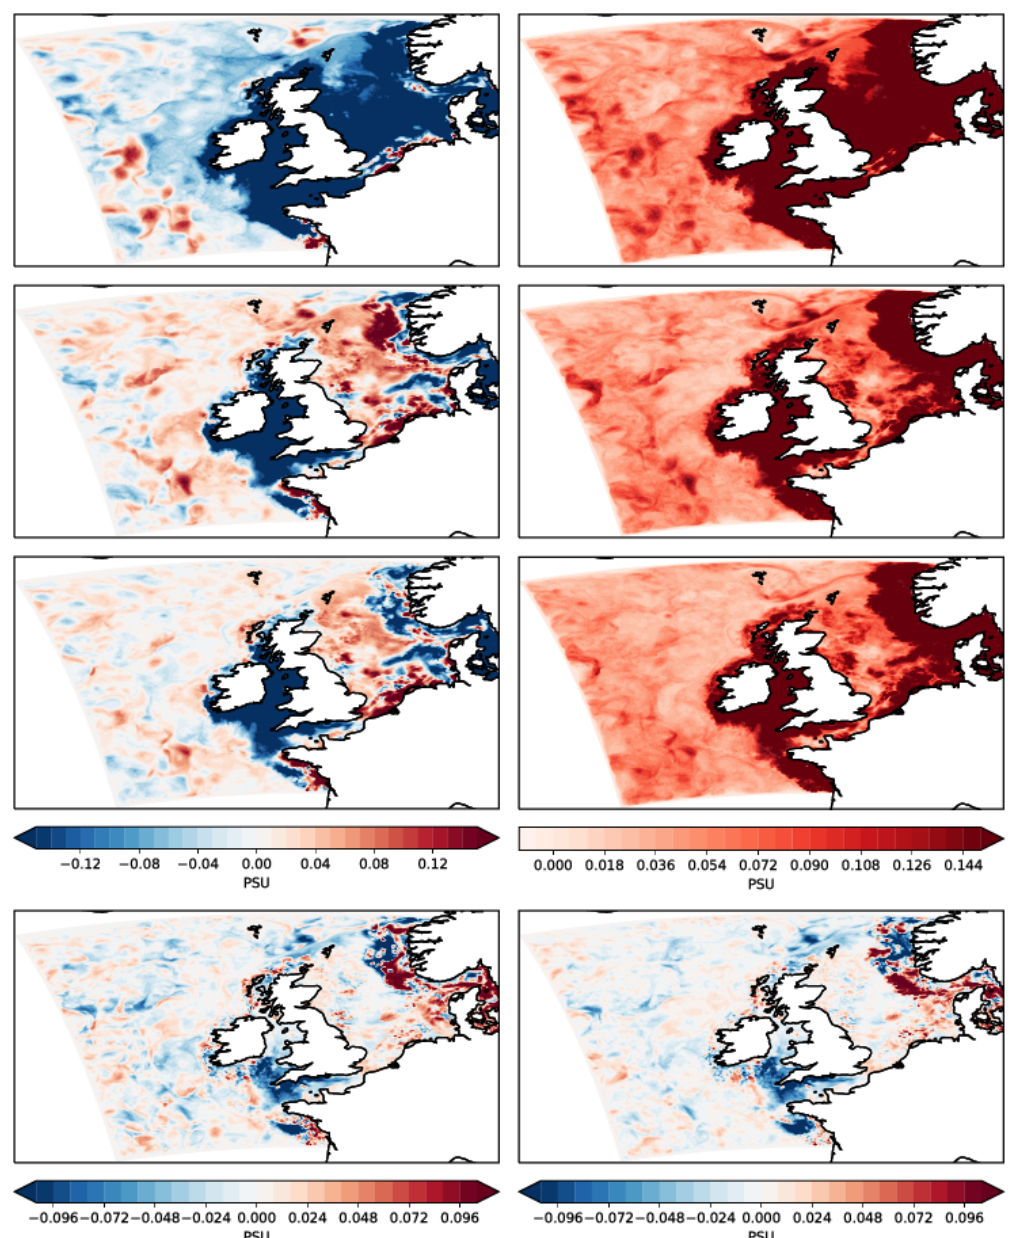
Figure 13. June 2018 vertically averaged salinity bias (left) and RMSE (right) for free run (top), control (second row) and LowErrSWOT experiments (third row). The difference (control – LowErrSWOT) in the absolute bias and RMSE between the control and LowErrSWOT experiments is also shown (bottom row) to highlight the impact of the additional SWOT